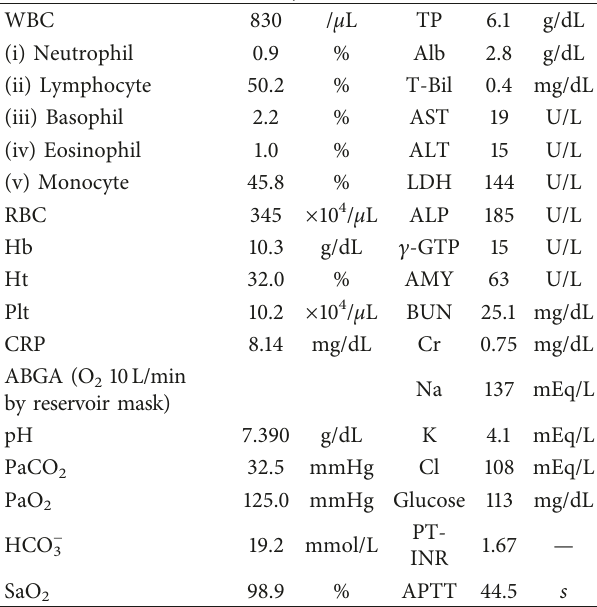
Table 1: Laboratory data on admission.